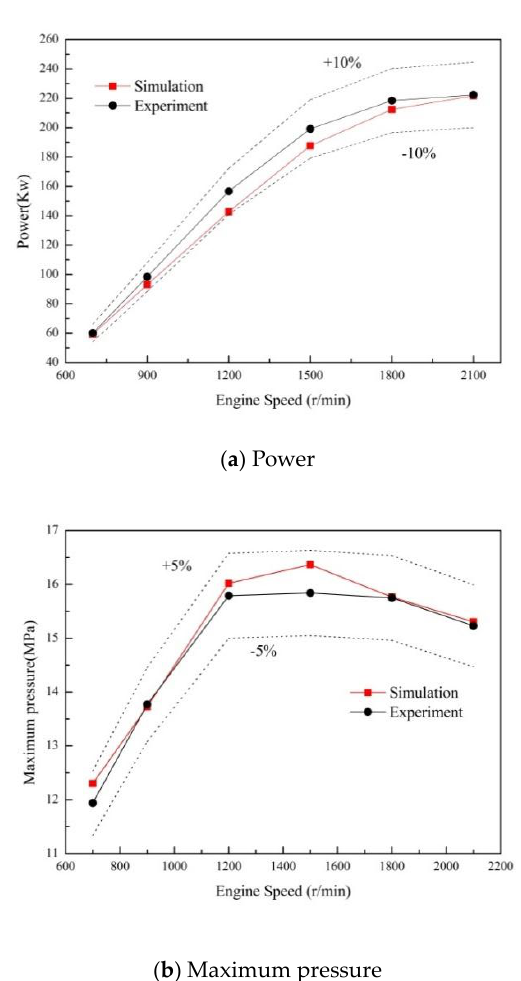
Figure 4. Experiment and simulation value of power and maximum pressure.